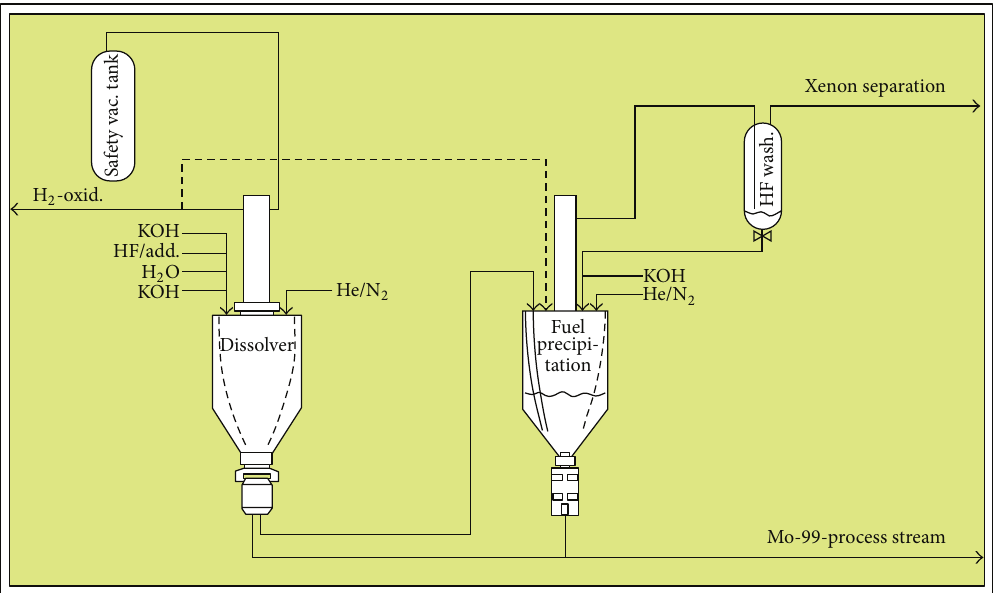
Figure 5: Combined operation of U 3 Si 2 dissolution and